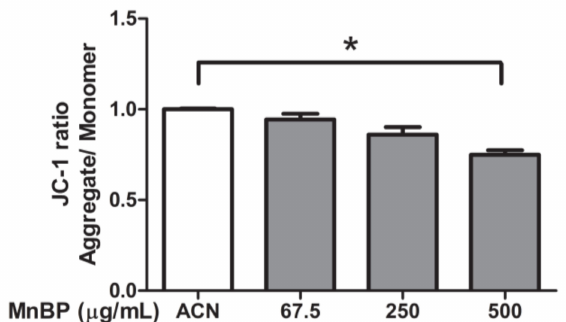
Figure 4. E ff ects of MnBP on the ratio of mitochondrial membrane potential in human granulosa cells. Human granulosa cells were seeded overnight in 96-well plates and treated with solvent control (ACN) and 67.5, 250, or 500 µ g / mL of MnBP for 72 h. The treated cells were stained with JC-1 solution (a cationic dye) and incubated at 37 ◦ C in 5% CO 2 for 30 min. The ratio of the fluorescence intensity of J-aggregates (excitation and emission at 550 and 600 nm, respectively) to that of J-monomer (excitation and emission at 485 and 535 nm, respectively) was used as the indicator of cell health. * p < 0.05.